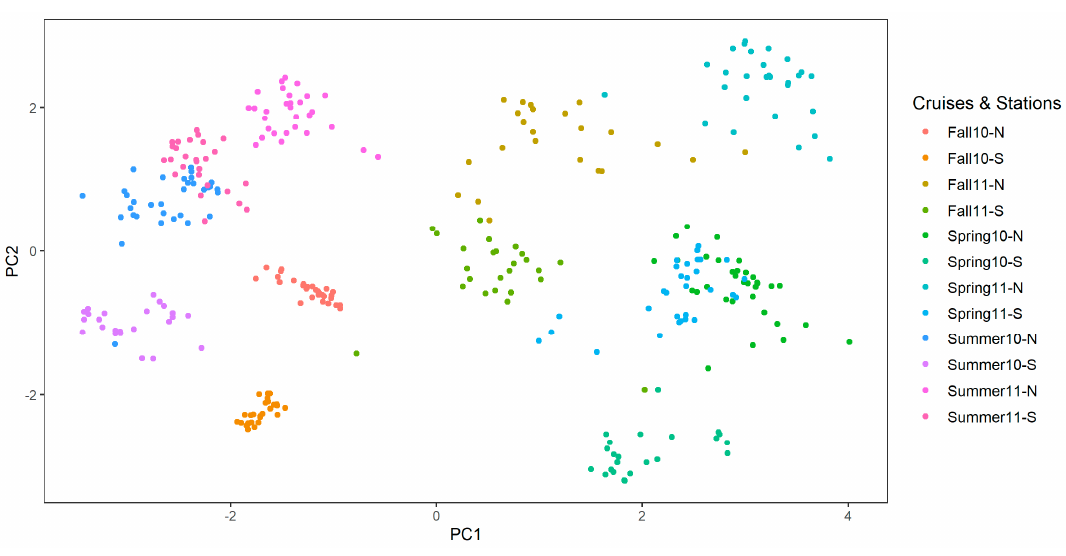
Figure 7. Principal component analysis of average temperature, salinity, and dissolved oxygen of the water above, at, and below pycnocline from each CTD cast at the North and South stations. Re-examining the environmental conditions with PCA grouping, the temperature variations among C, T, W group were bigger than the changes among vertical water layers and between LO